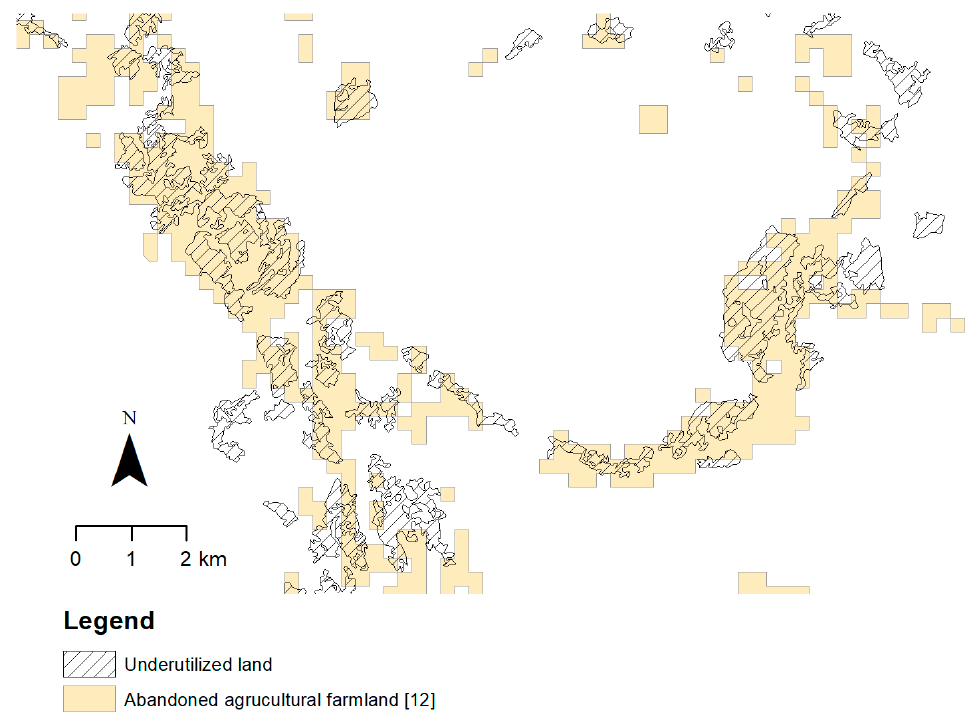
Figure 7. Comparison of the map of abandoned agricultural farmland produced by [12] for 2010 and the results of this study.